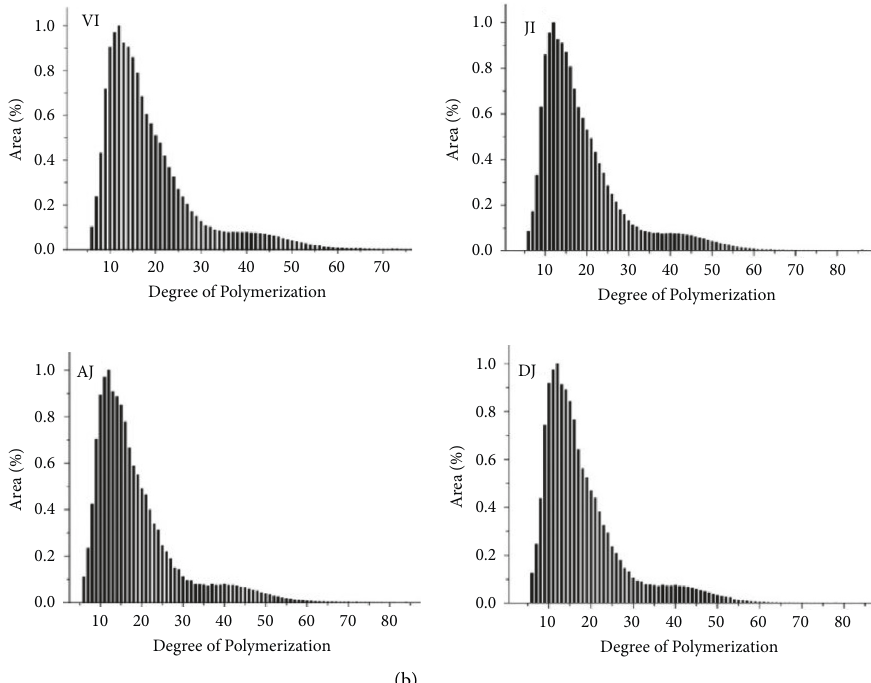
Figure 3: X -ray diffraction patterns (a) and amylopectin chain-length distributions (b) of various waxy rice starches. Vietnam indica